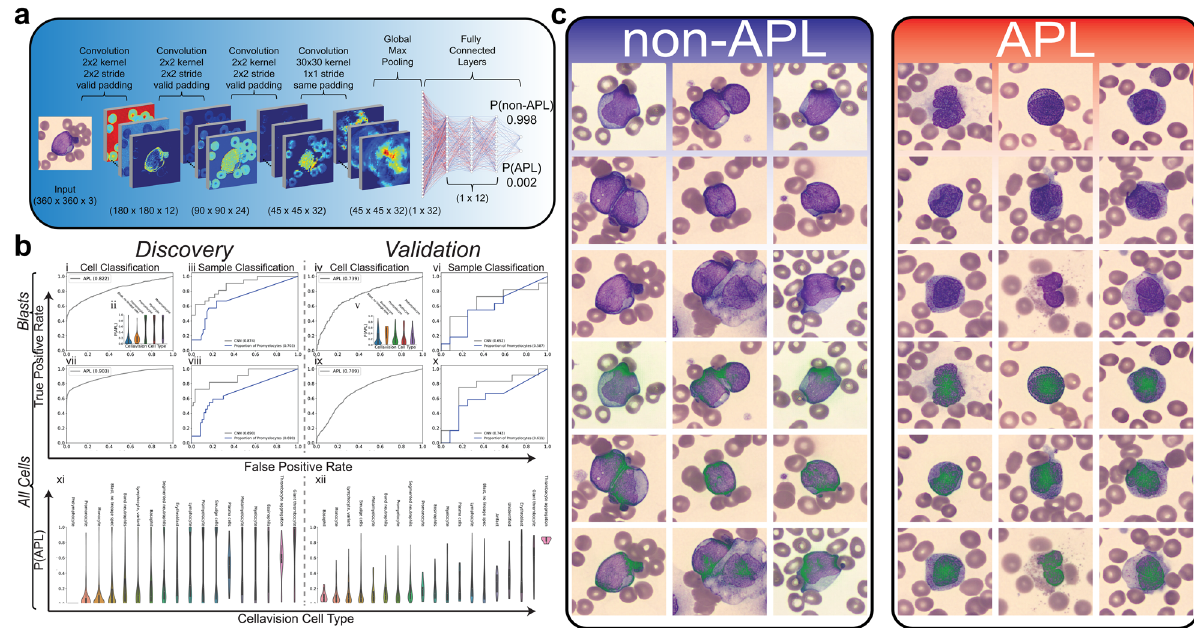
Fig. 1 Cell classi fi cation from peripheral smears. a A deep learning architecture was designed to train cell-level classi fi cation of white blood cells taken from peripheral smears. The proposed model takes in each segmented cell from CellaVision and applies four convolutional layers before conducting a global max-pooling operation followed by three fully connected layers and one classi fi cation layer to classify each cell as being non-APL/APL. b The proposed model was trained where CellaVision data was available on a discovery cohort of 82 patients and tested on an independent prospective validation cohort of 24 patients for which performance metrics are shown. Initially, the model was trained only on immature myeloid cells, here denoted as Blasts, and performance was assessed both at the cell (i,iv) and sample/patient (iii,vi) level